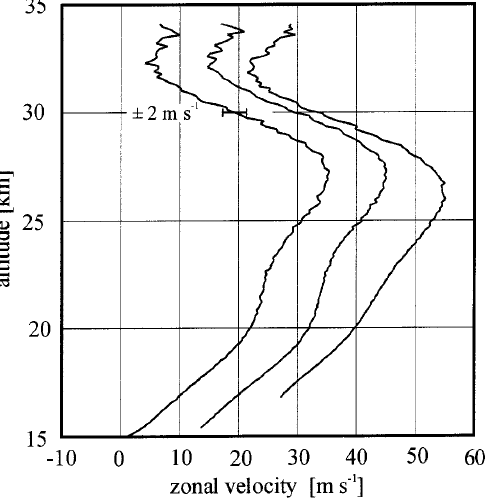
Fig. 11. Doppler wind measurements by the DWTS experiment, performed January 9, 1998. Shown are three profiles of the zonal component of the wind velocity. Integration times were about 10 min per profile. The velocity scale at the abscissa applies to the leftmost profile , all following profiles are o(cid:128)set to the right by 10 m s )